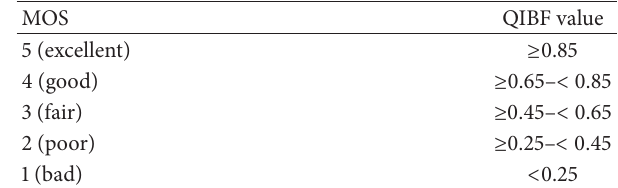
Table 3: QIBF versus MOS mapping [16].